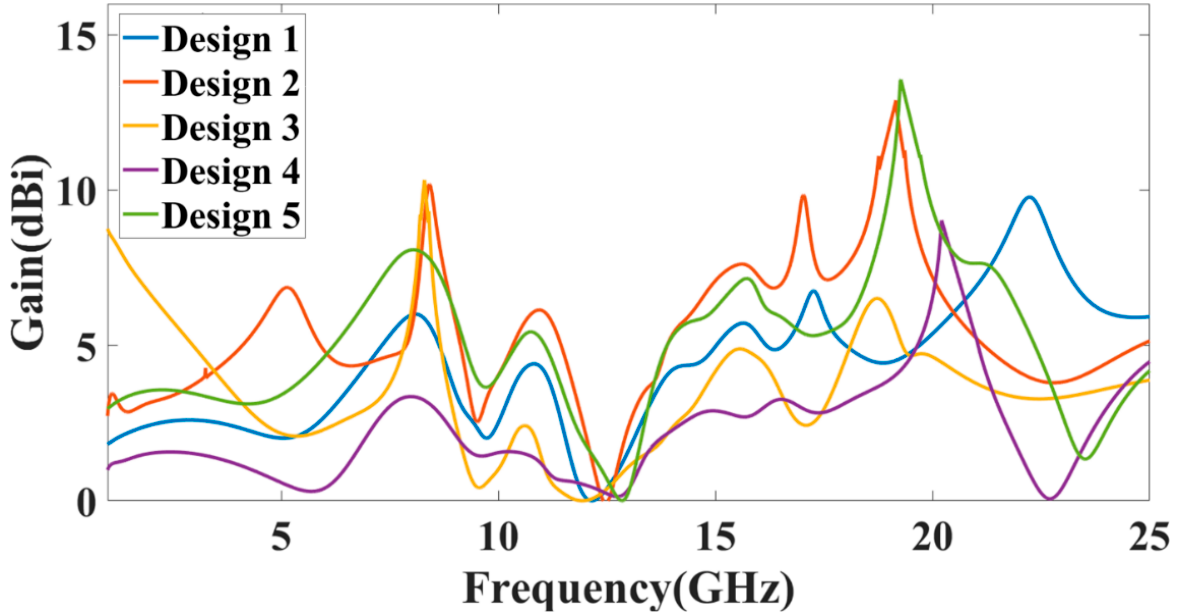
Figure 8. Variation in peak gain (dBi) for the different antenna designs.